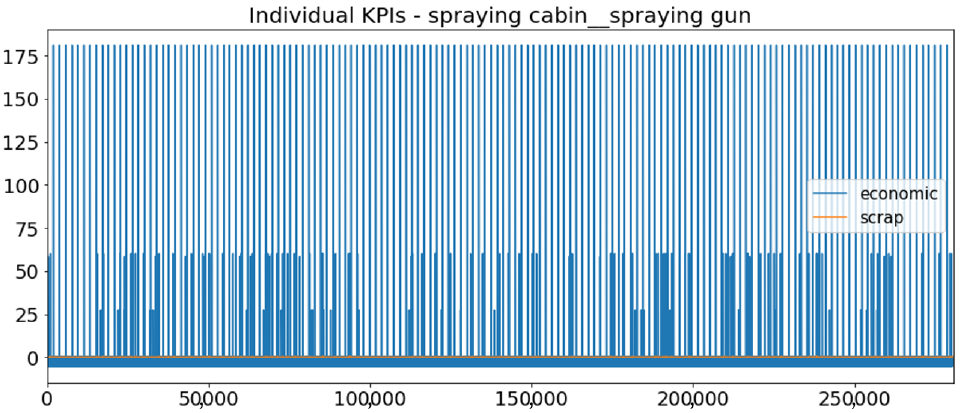
Figure 6. Individual KPI time series for the spraying gun yielded from running the model for the spraying cabin (GORENJE). The simulation interval has a length of 8